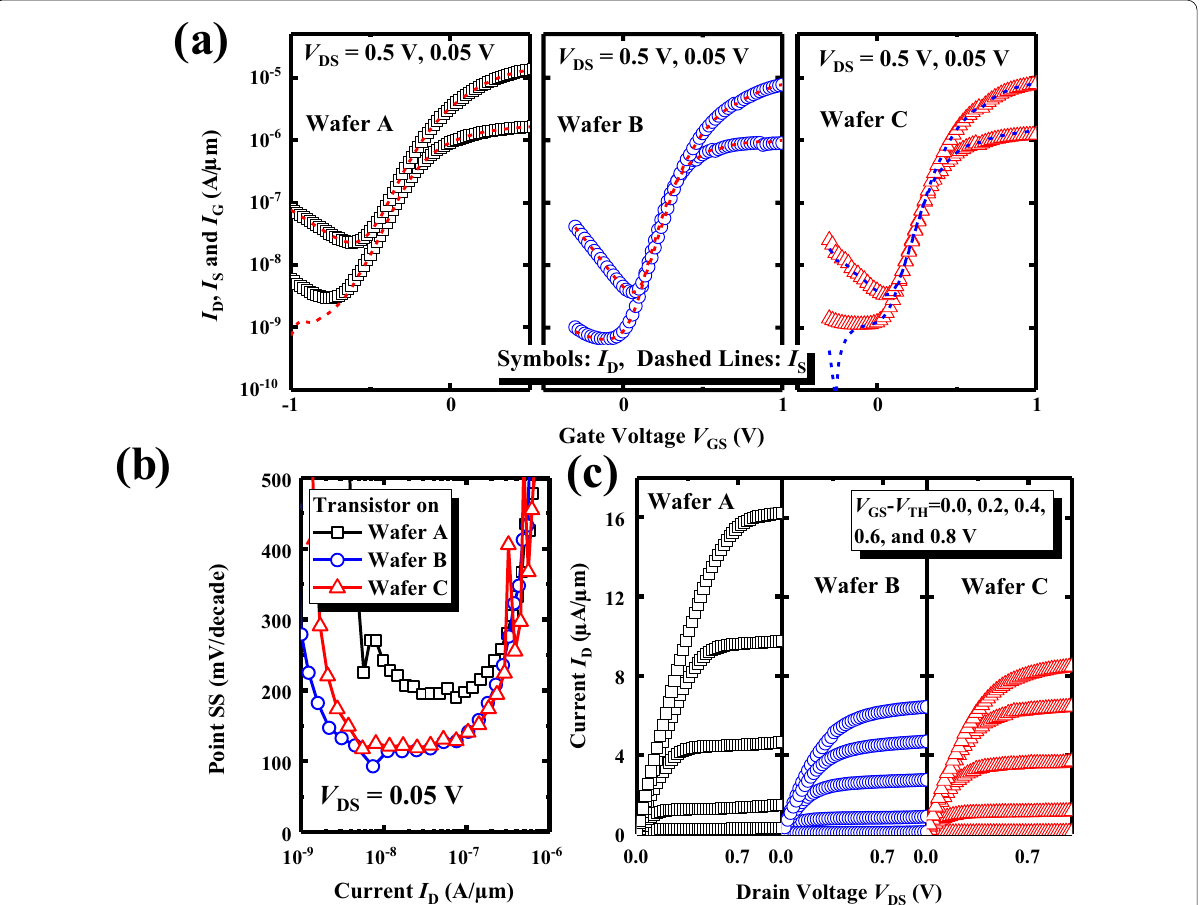
Fig. 4 a Measured I D and I S versus V GS curves of Ge nMOSFETs on wafers A, B, and C. b Point SS as a function of I D for the transistors. c I D – V D characteristics show that the Ge nMOSFET on wafer A has a higher drive current compared to the devices on wafers B and C